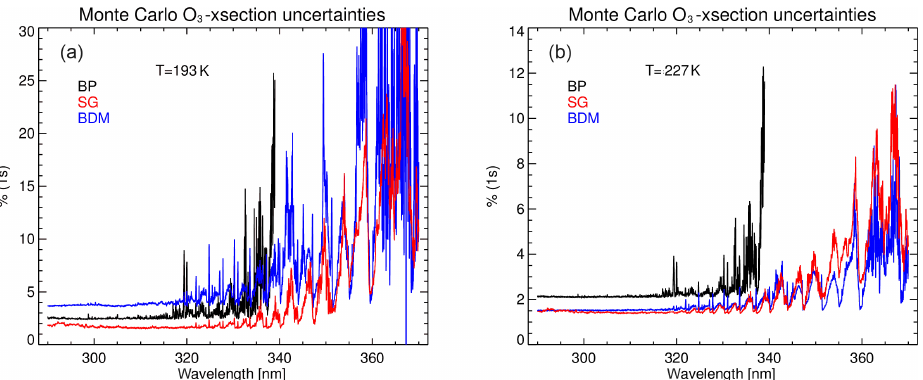
Figure 8. Uncertainty (1 σ ) of BP, BDM, and SG ozone cross sections at T = 193K (left) and 227K (right), respectively, from the MC simulation. Note the change in scale of the ordinate